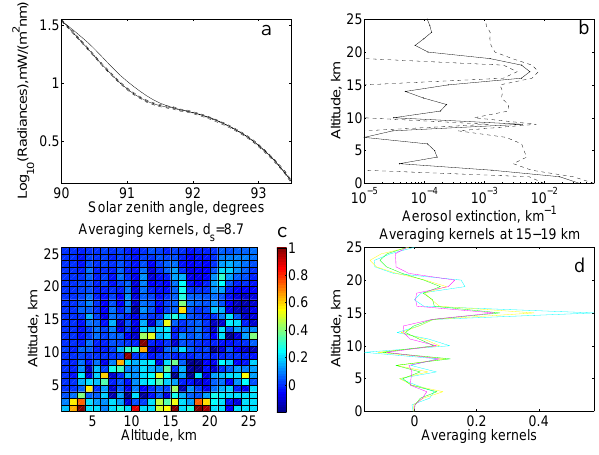
Fig. 8. Date of observation: 8 August 2010. (a) The measured twi- light curve (solid dotted line) fitted by the modelled one (solid line) and measurement uncertainties (dashed lines); (b) the retrieved aerosol profile and corresponding uncertainty (dashed line); (c) av- eraging kernels, corresponding degree of freedom d s is shown above the plot; (d) averaging kernels at altitudes 15–19km.